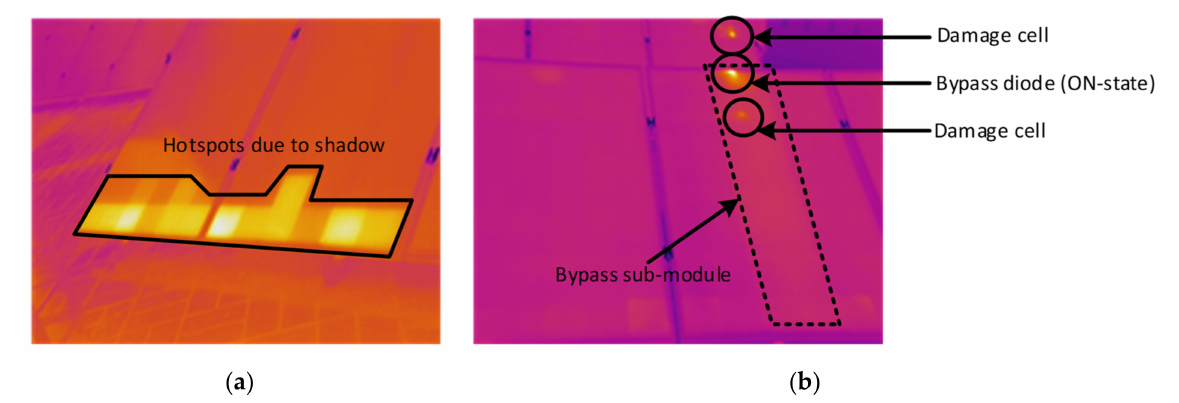
Figure 3. Infrared images: ( a ) shadow from front row PV modules and ( b ) damage PV cell in a PV